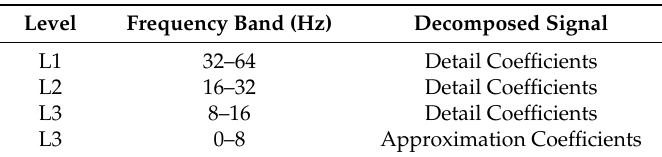
Table 1. Discrete wavelet transform (DWT) decomposition ( F s = 128 Hz, DB5, three decomposition levels). DB5: Daubechies order 5 mother wavelet.